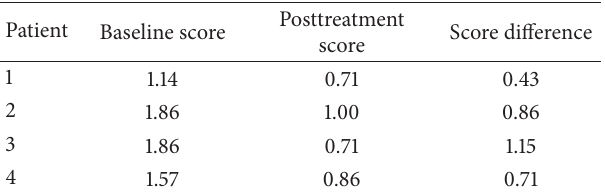
Table 2: The mean score of the Patient Assessment of Constipation Quality of Life (PAC-QOL) questionnaire before and after FES